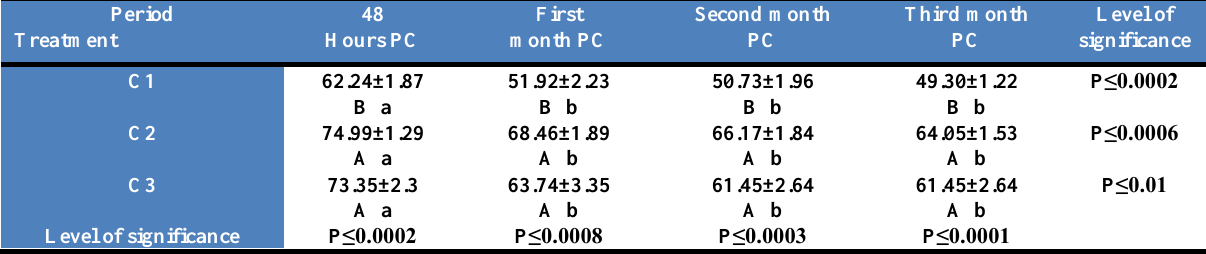
Means with capital superscripts within each column indicate comparison among treatments and small superscripts within each row indicate comparison among periods within each treatment. C1: Tris extender (Control group). C2: Tris extender + 0.5 mM α- lipoic acid. C3: Tris extender + 1.0 mM α- lipoic